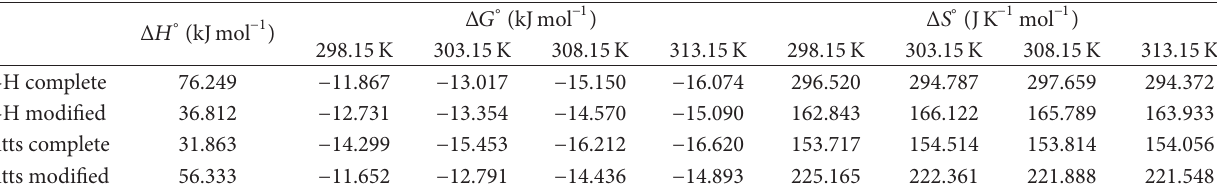
T 11: ermodynamic data for